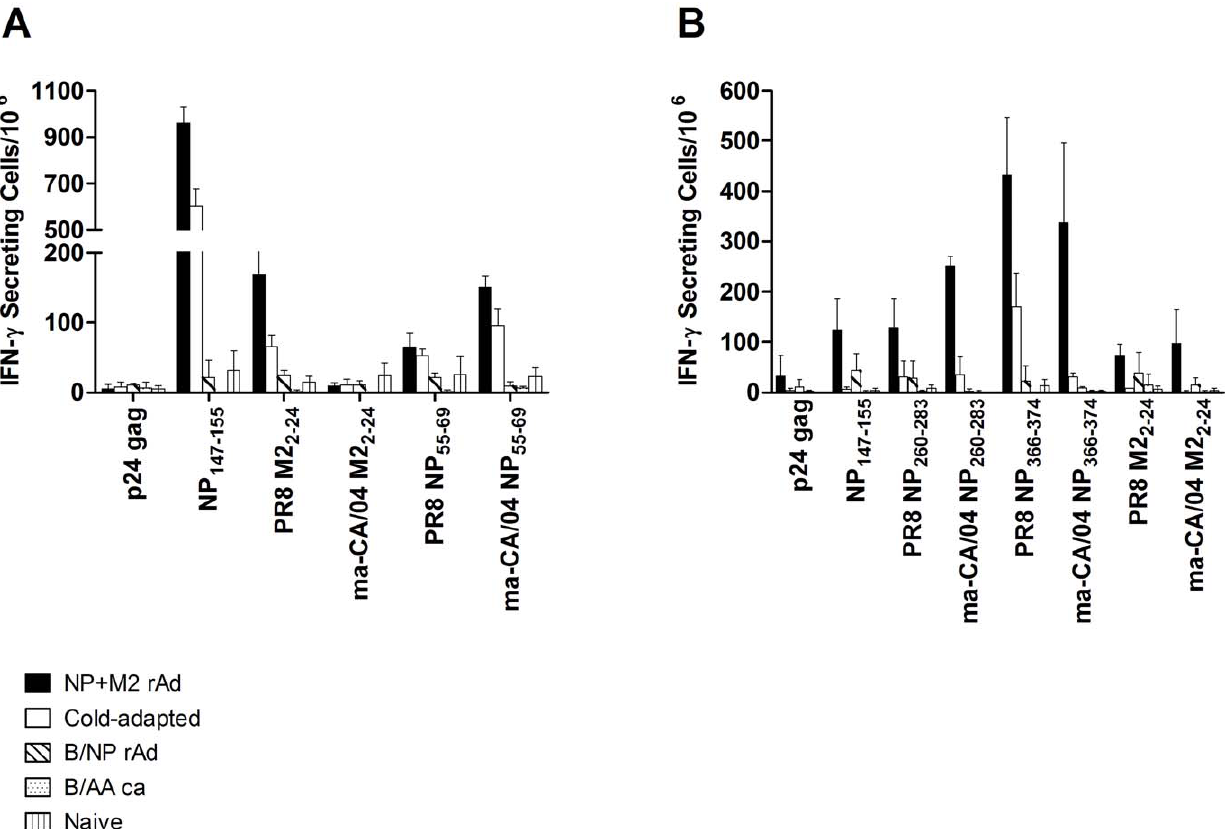
Figure 3. Lung T cell responses. IFN- c responses of lung T cells following stimulation with peptides of vaccine sequences or challenge virus sequences. BALB/c (A) or B6 (B) mice were immunized as in Figure 1, or left unvaccinated. Three weeks after immunization, T cell responses were determined by IFN- c ELISPOT as described in Materials and Methods. Pooled lung cells were tested using cells from 5 (BALB/c) or 7 (B6) mice per group. Shown are the mean of triplicate measurements of IFN- c secreting cells per million 6 SD.